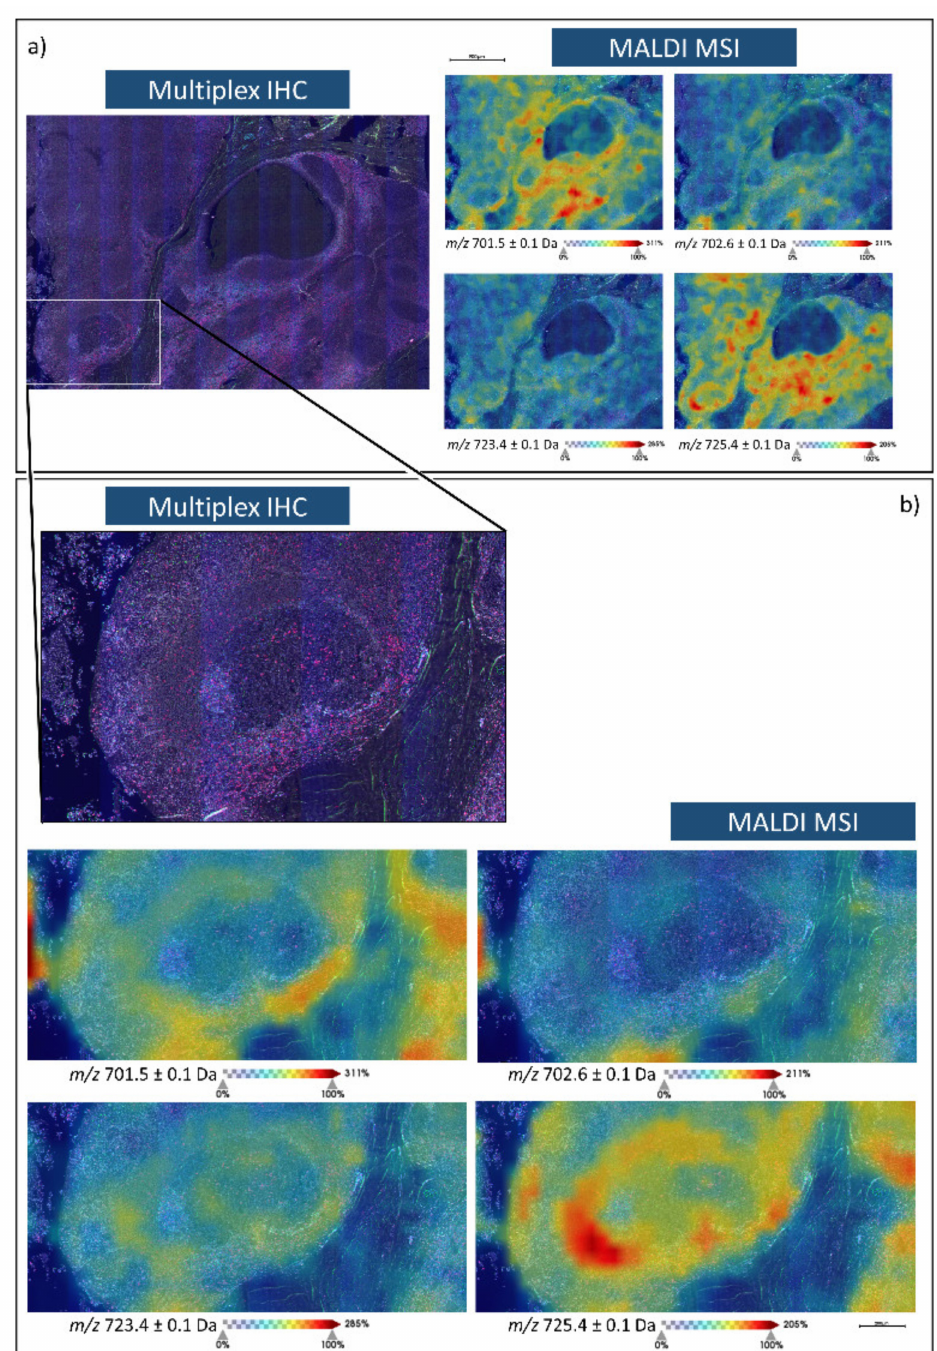
Figure 2. Multiplex immunohistochemistry (Blue, CD3; Green CD4; Red, CD8, Grey, 4 (cid:48) ,6-diamidino- 2-phenylindole (DAPI)) and MALDI-MS images of m / z 701. 5 [PA(18:0/18:1)], 702.6 [PE(40:2)], 723.4 [PA(20:4/18:0)], and 725.4 [PA(18:0/18:3)] in human tonsil tissue. ( a ) is representative of a larger area of the tonsil which encompasses both lymphocytes and epithelial cells whilst ( b ) provides an inset from a follicle that is surrounded by a denser distribution of T